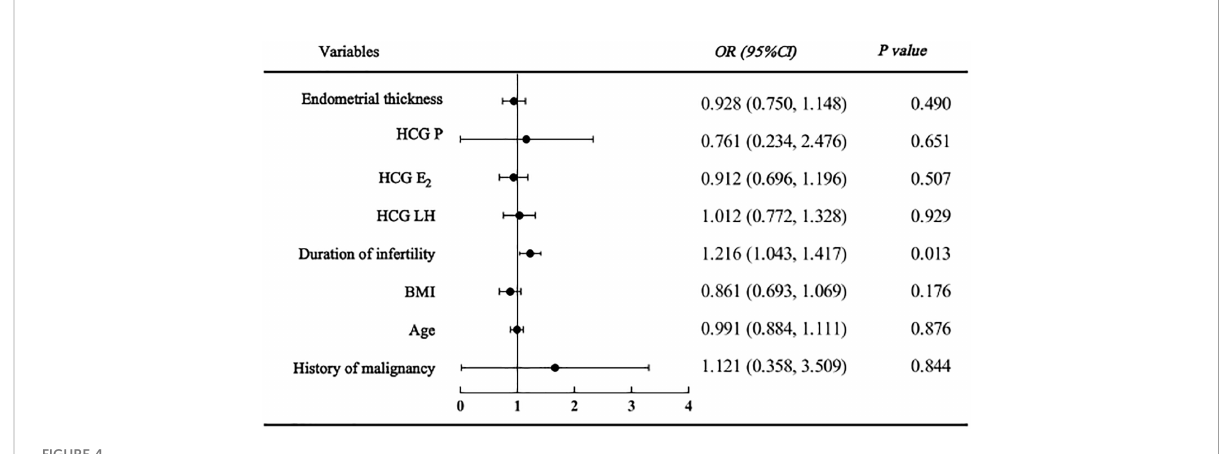
FIGURE 4 Logistic regression analysis forest plot of adverse pregnancy affecting factors.